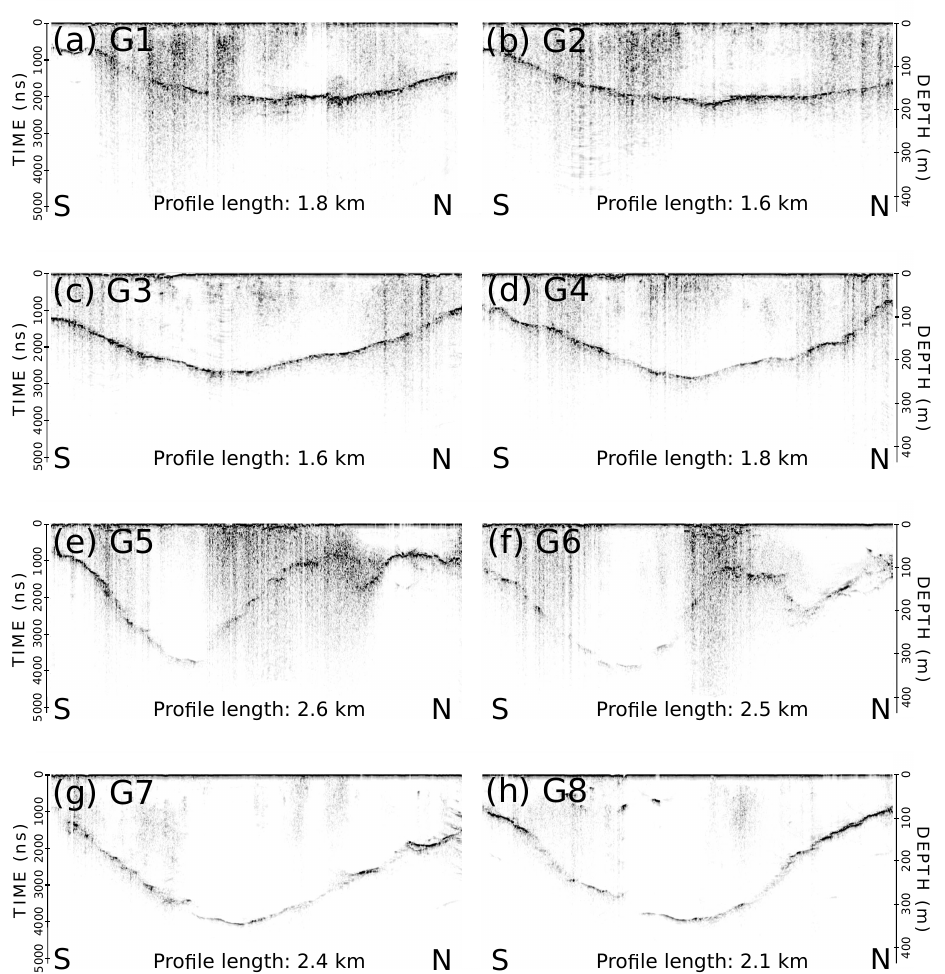
Figure 3. ( a – h ) GPR measurements from 2018 for the profiles G1–G8 in Figure 2a.